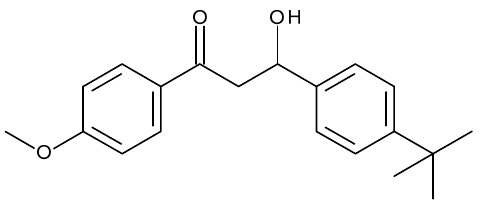
Figure 8. Chemical structure of 3-(4-tert-butylphenyl)-3-hydroxy-1-(4-methoxyphenyl) propan-1- one